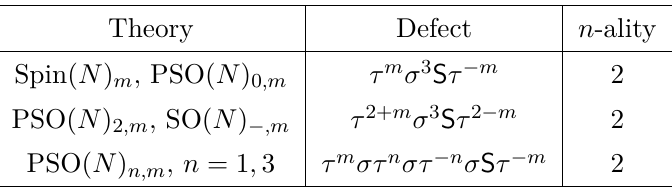
Table 7 . Non-invertible symmetries of so ( N ) with N ∈ 4 Z + 2 at τ YM = i